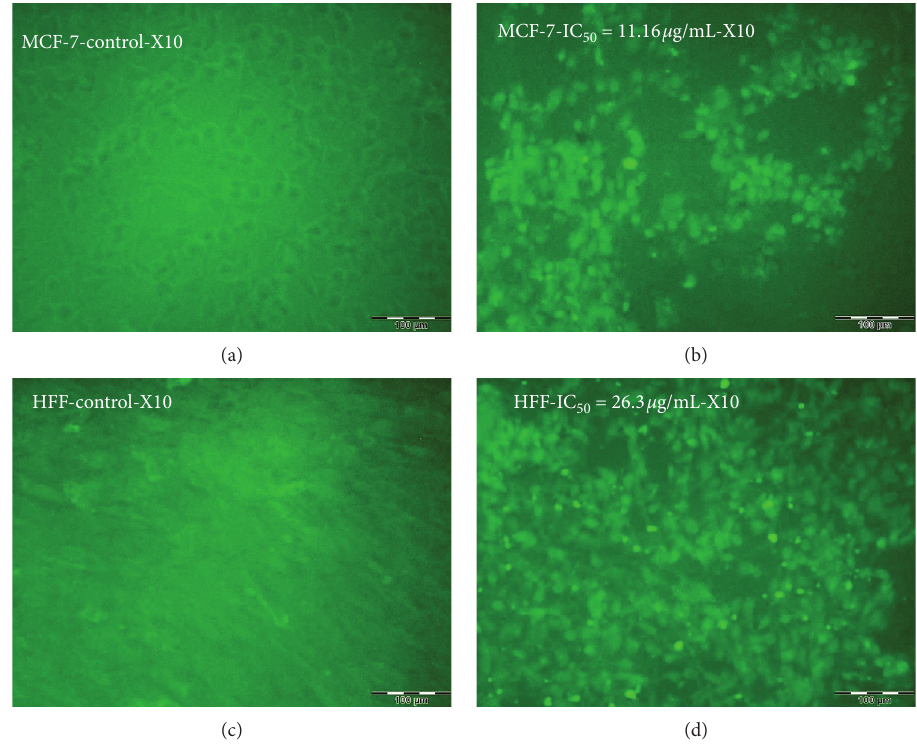
Figure 5: Effect of zinc oxide nanoparticles (ZnO-NPs) on apoptotic morphological changes in MCF7 and HFF cell lines by Hoechst staining. (a) Untreated MCF7 cells. (b) Morphology of the MCF7 cells after ZnO-NP treatment with IC 50 dose (IC 50 � 11.16 μ g/mL). (c) Untreated HFF cell morphology. (d) HFF cells’ morphology after ZnO-NP treatment with IC 50 dose (IC 50 � 26.3 μ